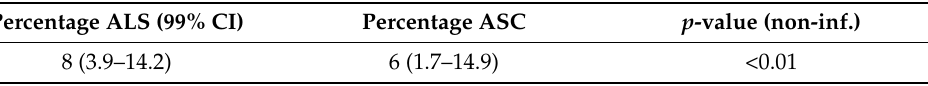
Table 4. Confidence Interval of ALS rate to calculate p -value of non-inferiority. Condition of non-inferiority . Prolapse recurrence variation rate between ASC and ALS not exceeding 10%. p -values < 0.05 were considered statistically significant. ALS: Abdominal Lateral Suspension; ASC: Sacral Colpopexy; CI: confidence interval; non-inf: non-inferiority. p -value